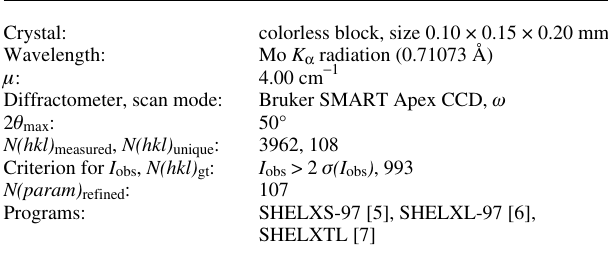
Table 1. Data collection and handling.